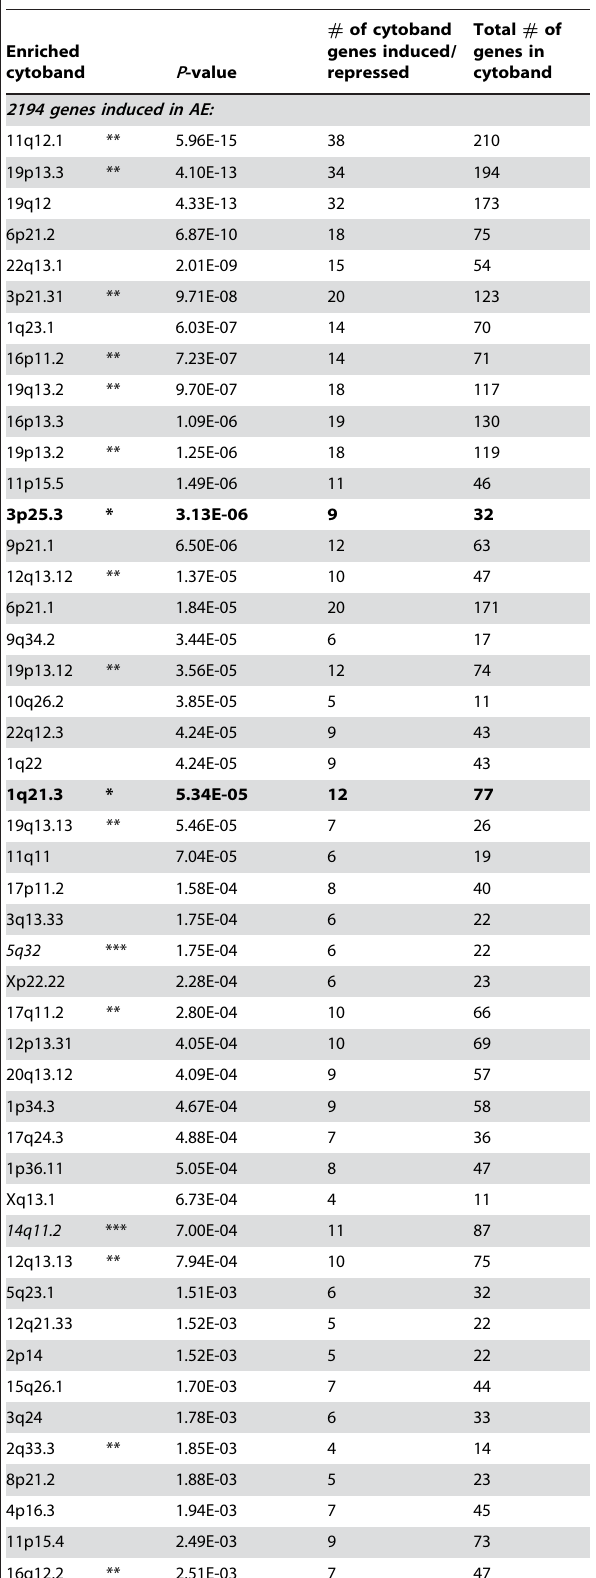
cells in AE lesional skin (data not shown).